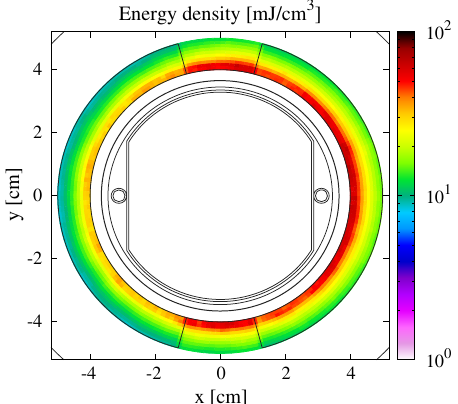
FIG. 11. Simulated transverse energy density distribution from FLUKA, integrated over the event, in D4.L4 coils at the location where the maximum energy deposition occurs during the inter- mediate-duration orbit-bump